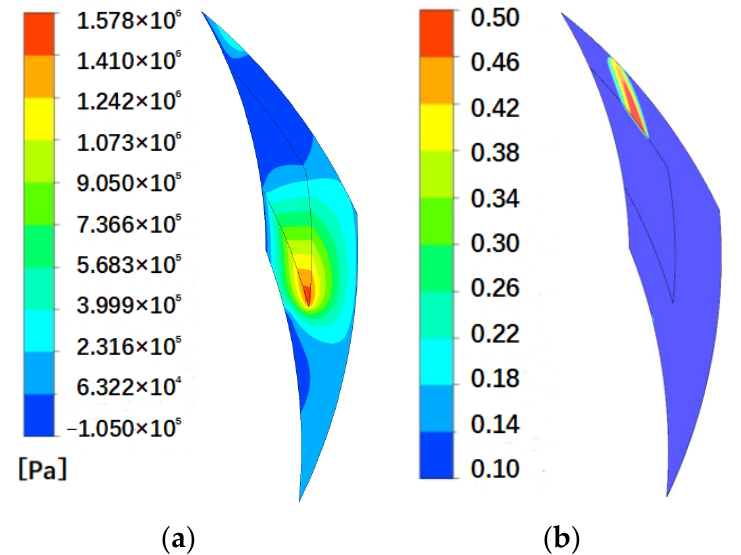
Figure 6. Calculation results of continuous phase flow field. ( a ) Film pressure distribution; ( b ) Volume fraction distribution of gas phase.